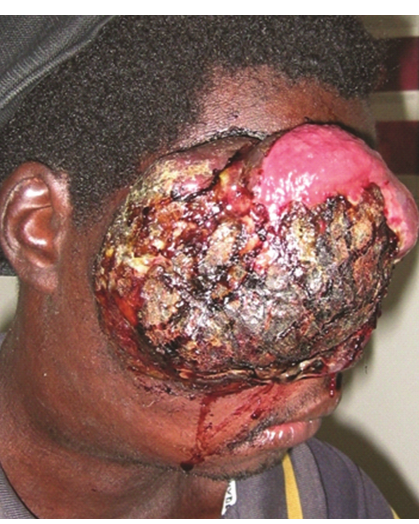
Figure 1: Large friable exophytic mass protruding from the right orbit. Note the necrotic areas and exudative/hemorrhagic secretions involving the soft and bony structures.